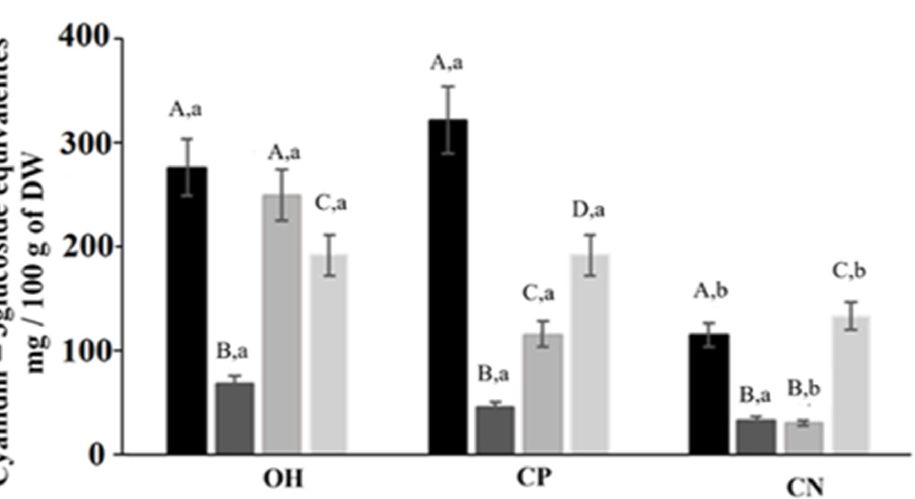
Table 1. Anthocyanins profile from OH, CONV, and CT methods for each solvent (µg/g DW).